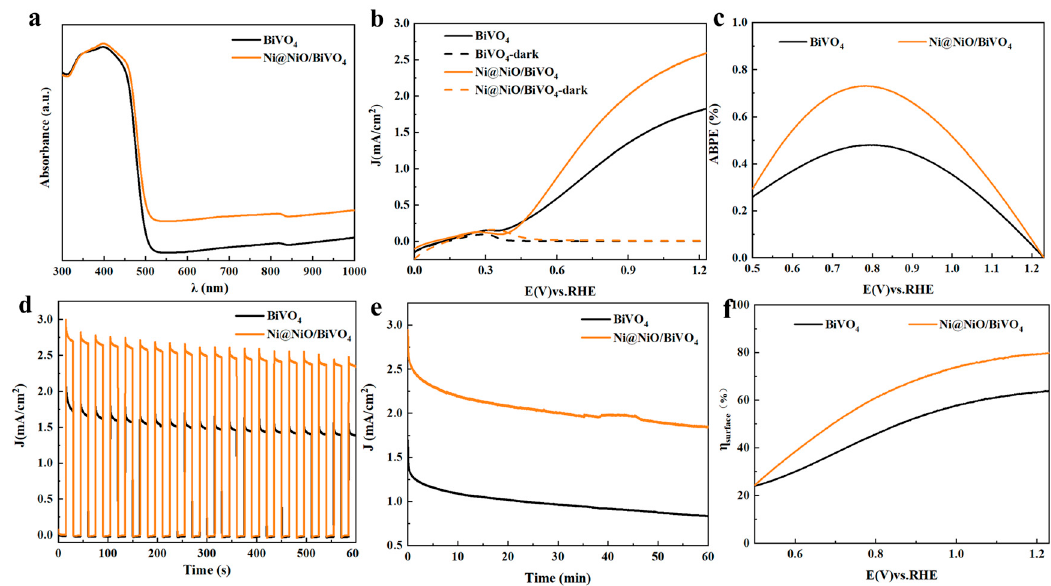
Figure 3. ( a ) Absorption spectra of BiVO 4 and Ni@NiO/BiVO 4 films. ( b ) LSV curves of BiVO 4 and Ni@NiO/BiVO 4 photoanodes; ( c ) ABPE and ( d ) J-t curves measured at 1.23 V RHE under chopped AM 1.5G illumination in a borate buffer solution; ( e ) long-term J-t curves of BiVO 4